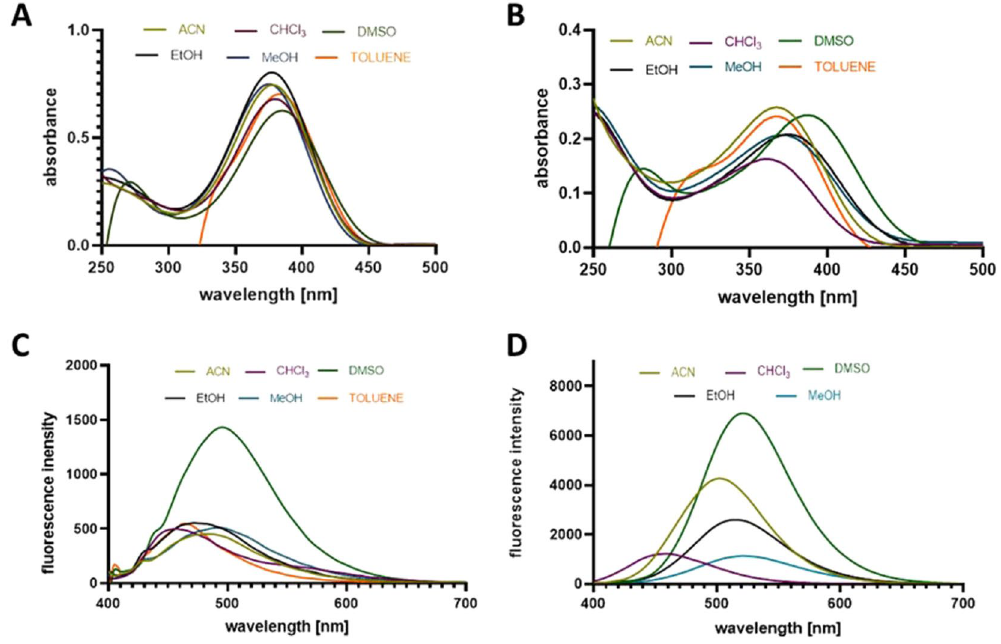
Figure 2. Absorption spectra of BC15 ( A ) and SC2 ( B ) and the emission spectra of BC15 ( C ) and SC2 ( D ) in solvents with different polarities. The absorbance in toluene is suppressed du to intermolecular interactions ( π